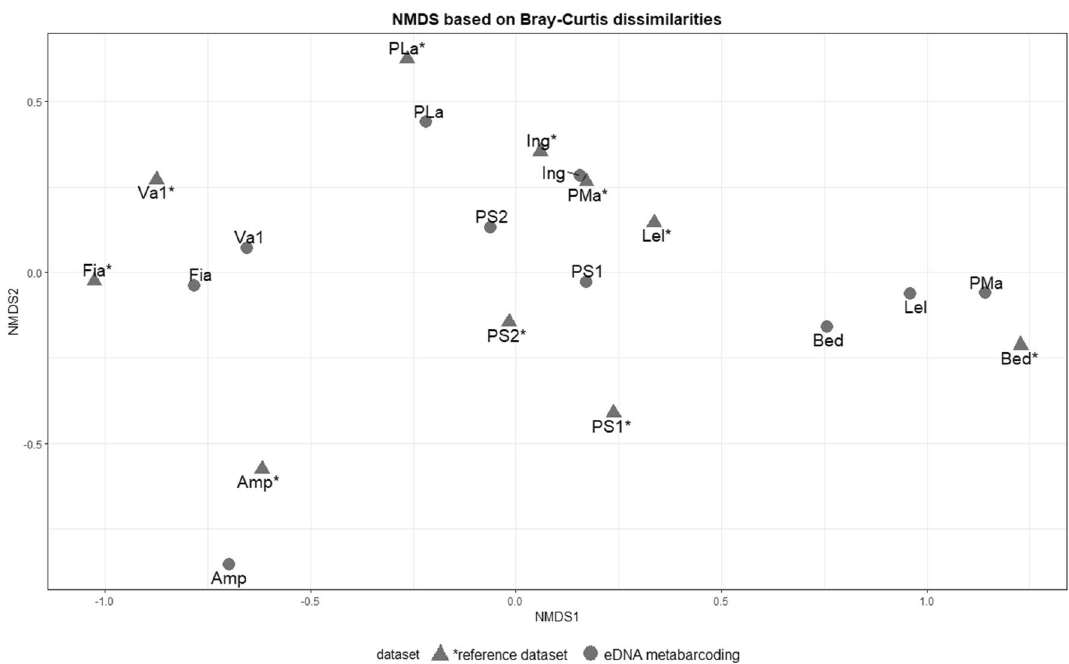
Figure 4. Non-metric multidimensional scaling (NMDS) plot, based on two Bray- Curtis dissimilarity matrices for Rana temporaria in the Province of Trento Italy, for two datasets: sites represented by a triangle and labeled with ‘*’ refer to the standard genetic survey dataset 41 ; sites represented with a circle and without ‘*’ refer to the eDNA metabarcoding